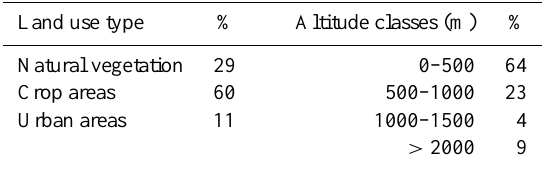
Table 2. Land cover type and altitude classes (in percentage) of the meteorological stations used in hourly, daily and monthly R s